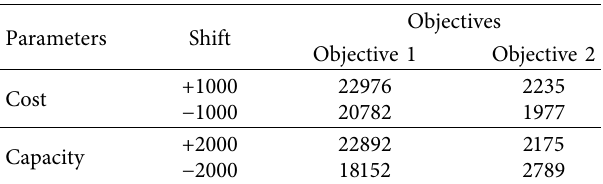
Table 12: Sensitivity